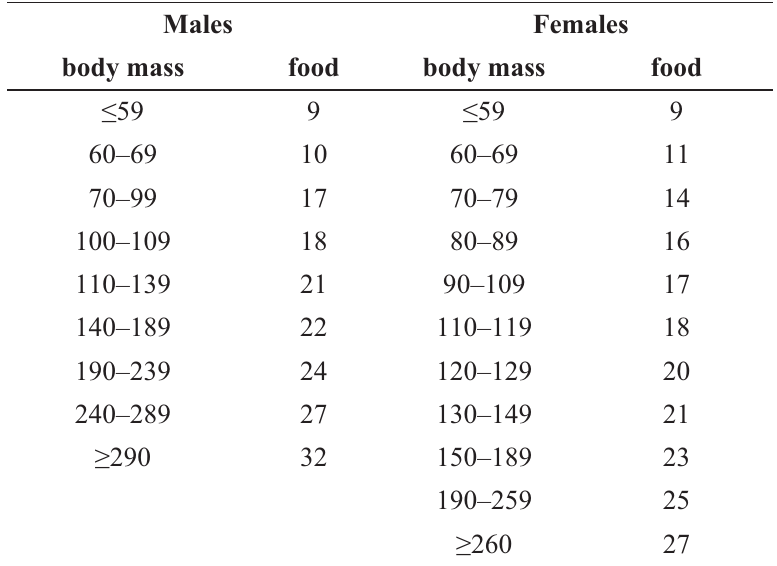
Table 2. Daily food provision (g, ±1) as determined by animal body mass (g). Males body mass